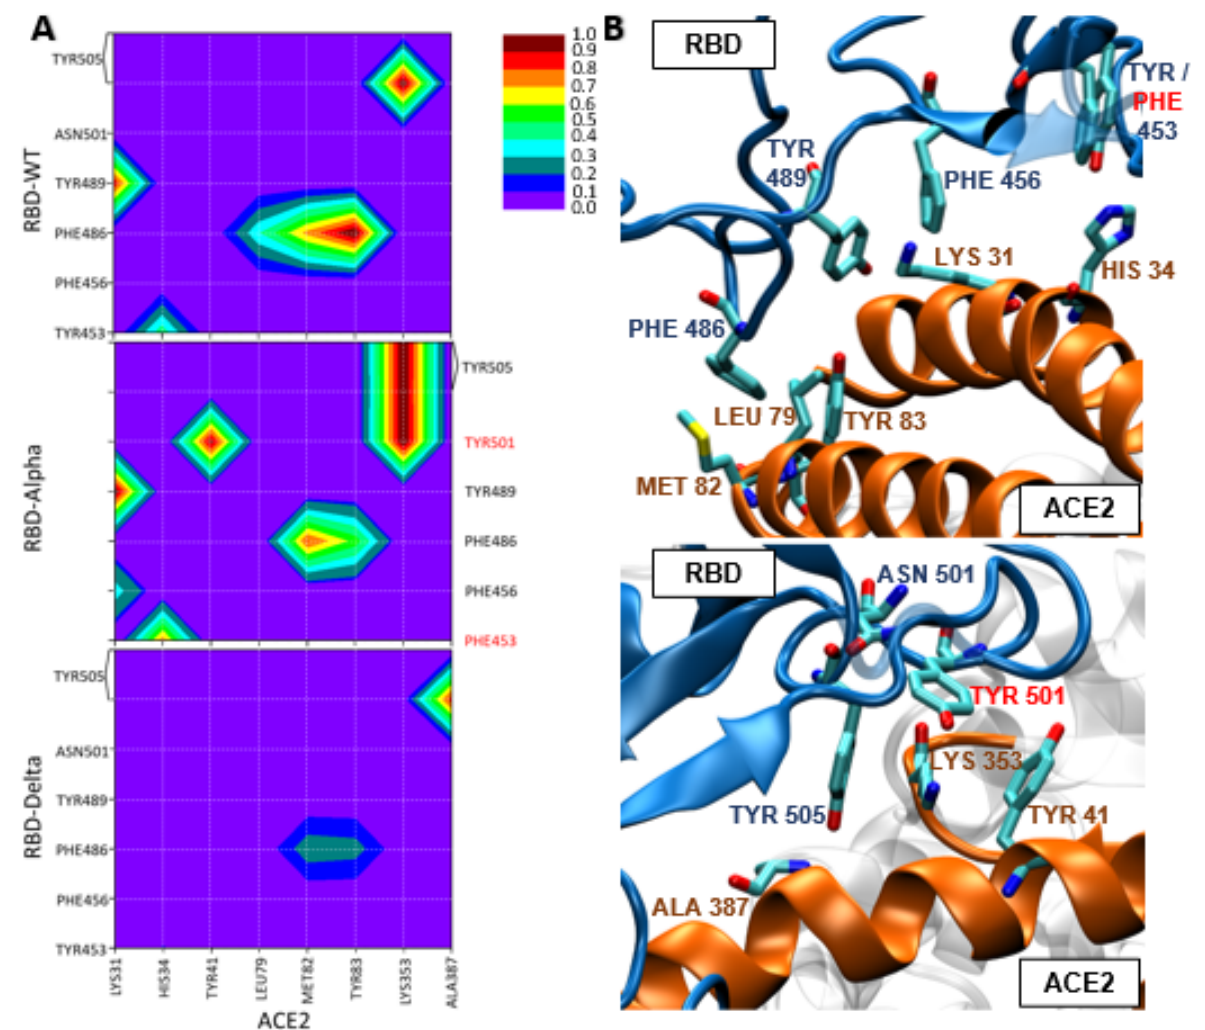
Figure 3. ( A ) 2D maps of hydrophobic interactions between WT, Alpha or Delta-RBD and ACE2 residues. ( B ) Representative snapshots showing the amino acids involved in the hydrophobic interactions. Snapshots are based on the structures of ACE2/Alpha-RBD cluster 0 and ACE2/WT-RBD cluster 2. Point mutations are depicted in red.